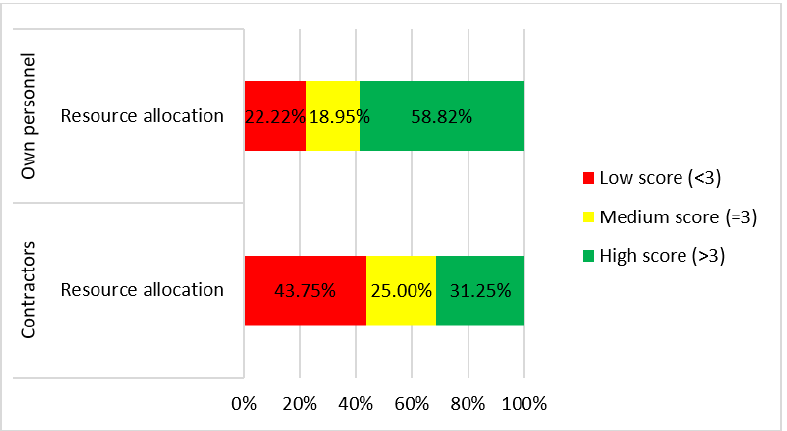
Figure 17. Categorized BARS percentages for formalization, by contractual relationship.